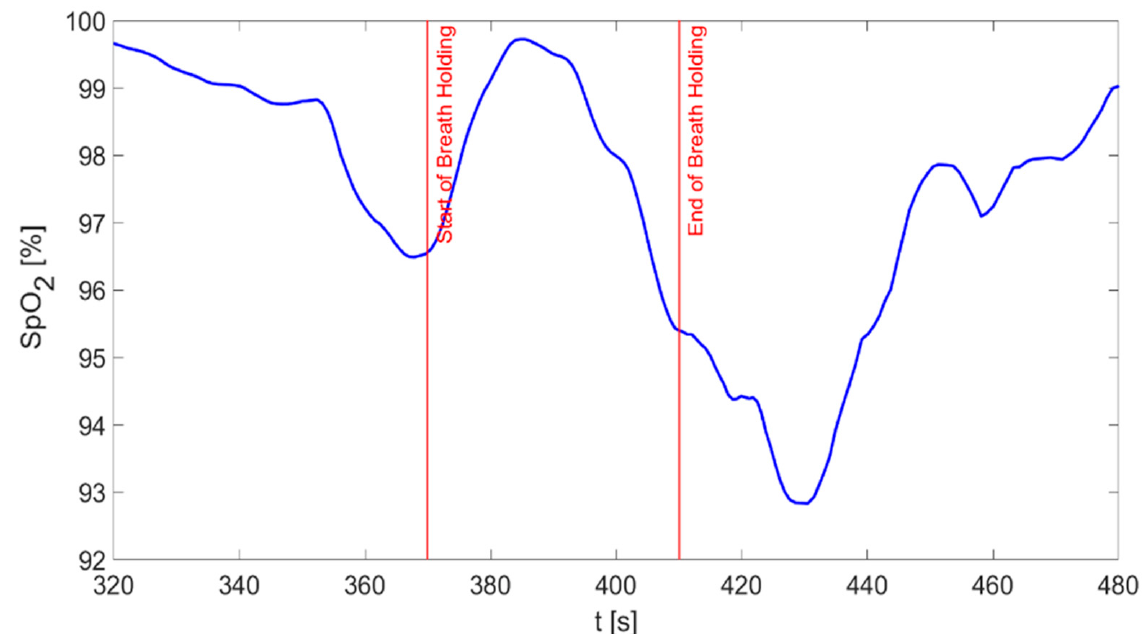
Figure 7. Instantaneous values of SpO 2 during a 160-s window. The vertical red lines delimitate the 40-s BH phase.